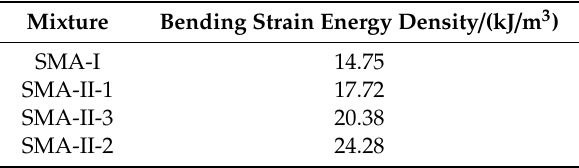
Table 20. Bending strain energy density of asphalt mixtures.